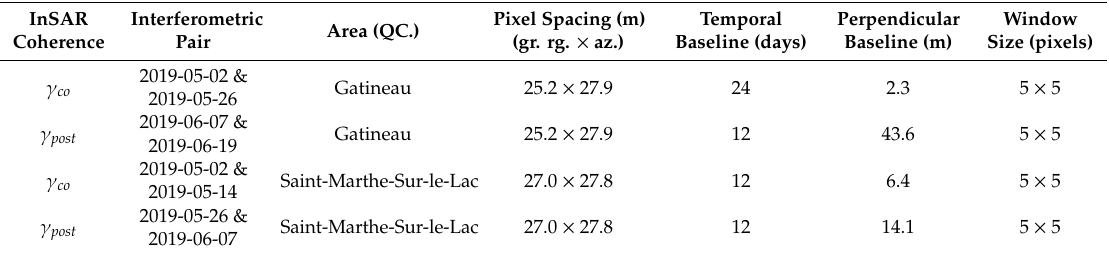
Table 4. InSAR coherence data used to map urban flood in Gatineau and Sainte-Marthe-sur- le-Lac, Quebec. InSAR Interferometric Area Coherence Pair